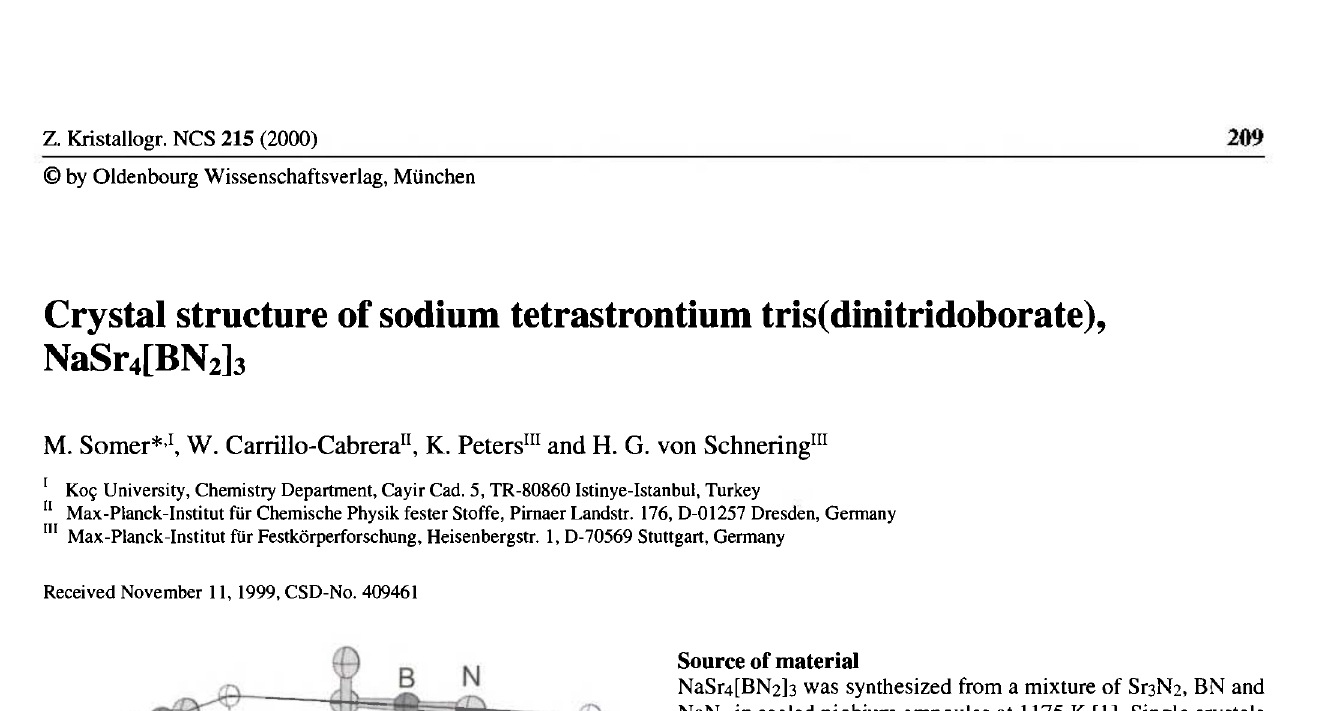
Table 1. Data collection and handling. Crystal: Wavelength: μ: Diffractometer, scan mode: 20max: N(hkl) measured, N(M/) U nique: Criterion for F 0 bs, N(hkl) gt : N(param) K fined: